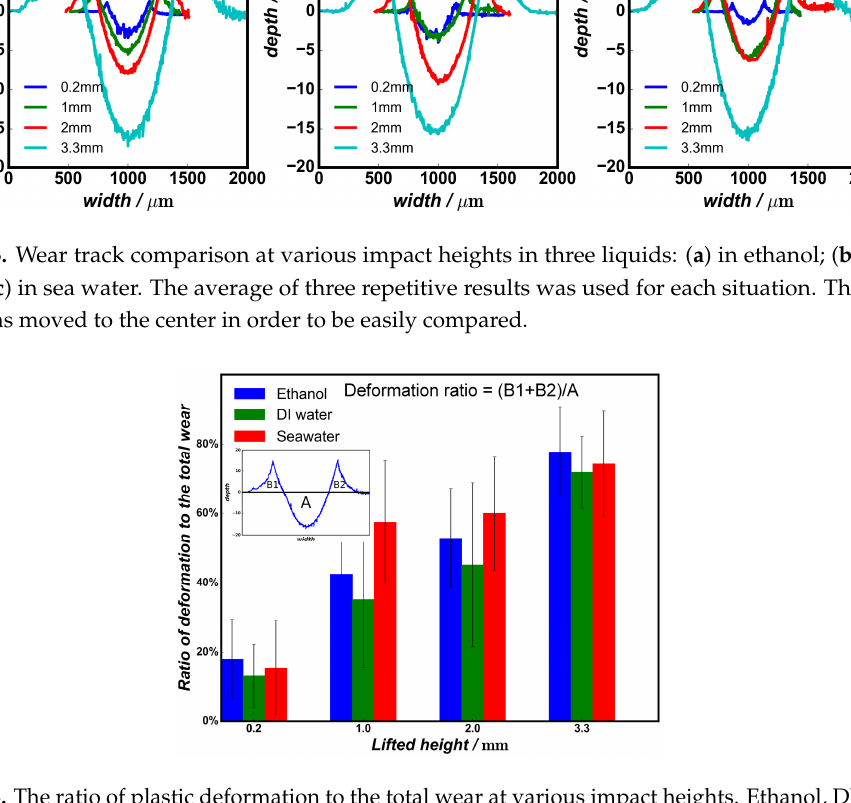
Figure 4 . The ratio of plastic deformation to the total wear at various impact heights. Ethanol, DI water and seawater were used to vary corrosivity. The error bar stands for one standard deviation of three repeated results. The embedded small figure represents the cross section of the round wear track.